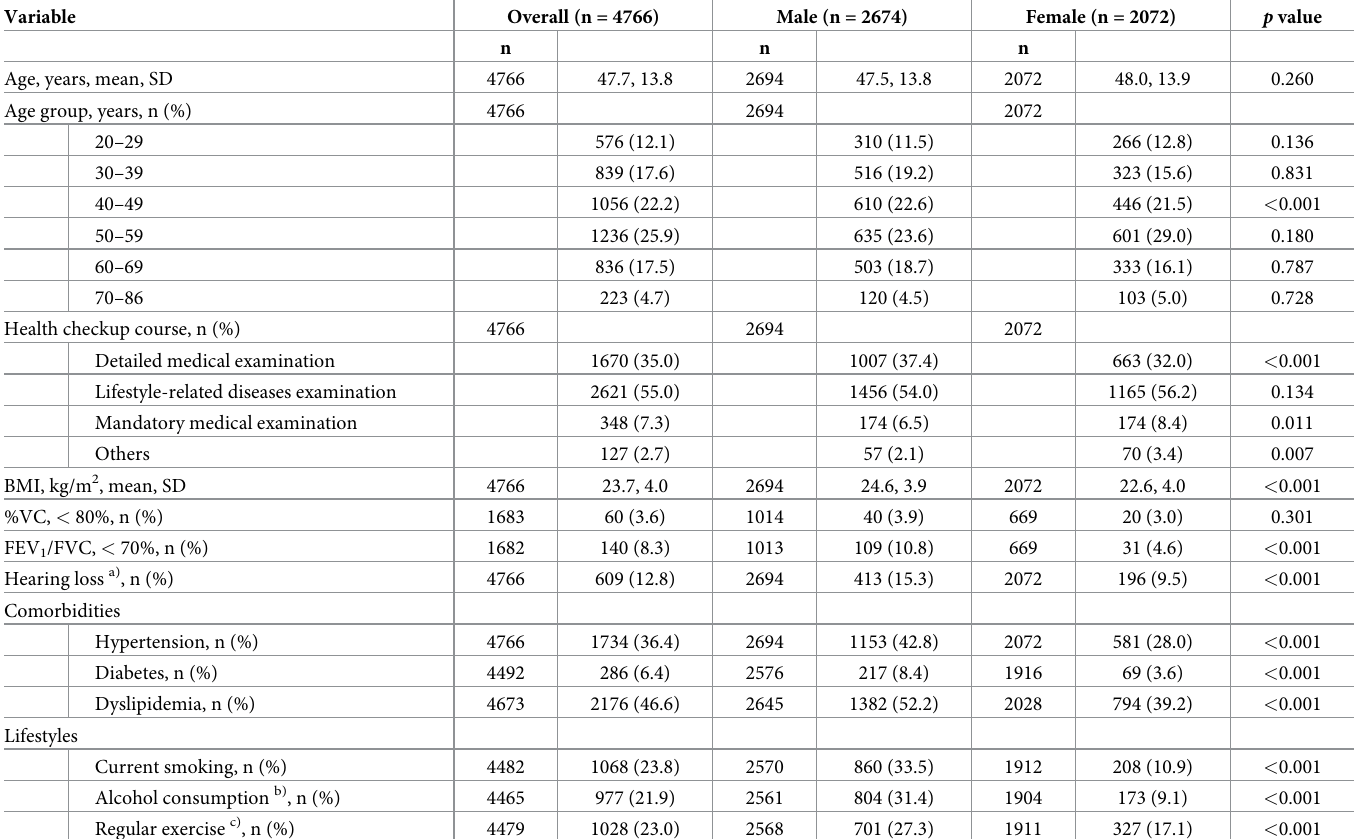
Table 1. Characteristics of study subjects (n =